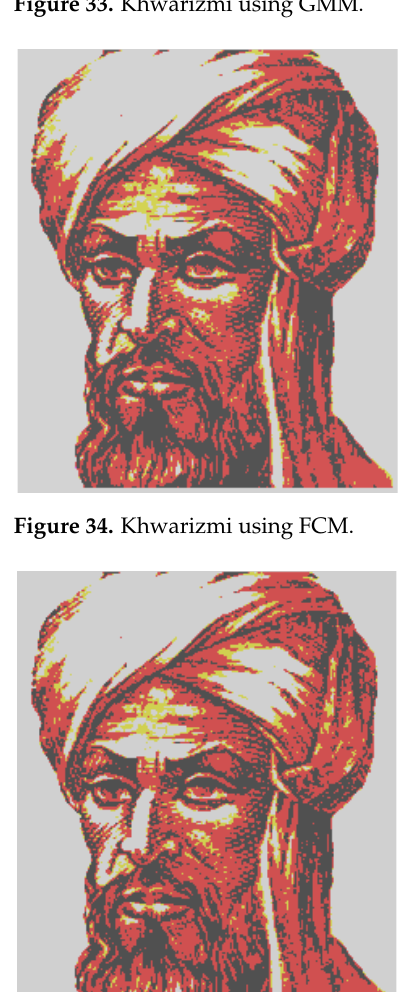
Figure 35. Khwarizmi using FP-Conv-CM. Analysis of MSE and PSNR shows that our method permits small improvements in the compression. Analysis of SSIM shows that our method provides an important improvement in compression